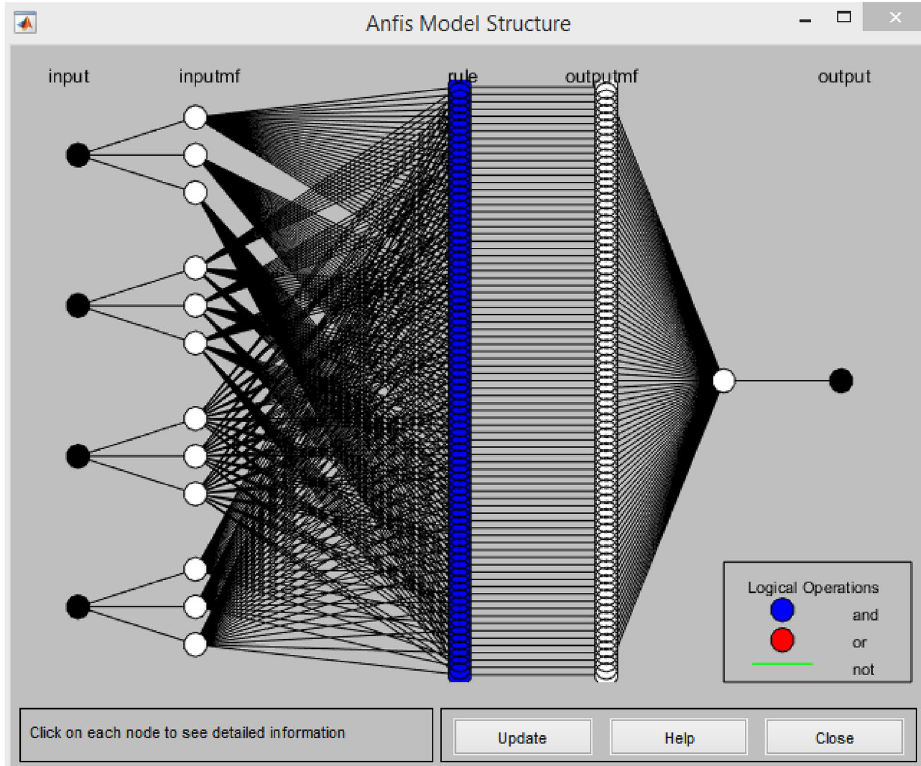
Figure 17. ANFIS model structure generated from MATLAB